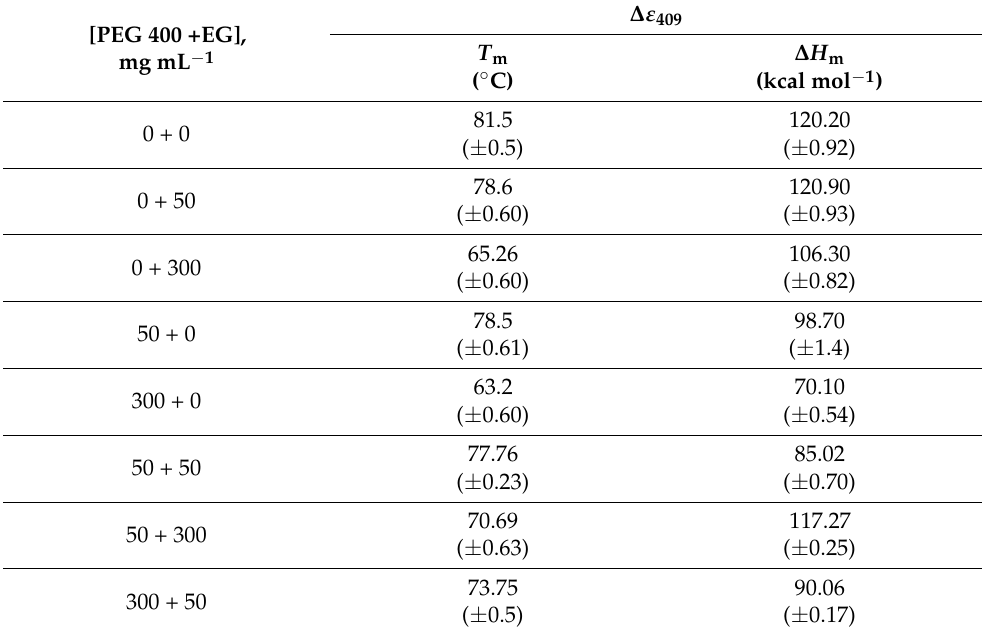
Table 2. Thermodynamic parameters estimated from thermal denaturation of Mb with various